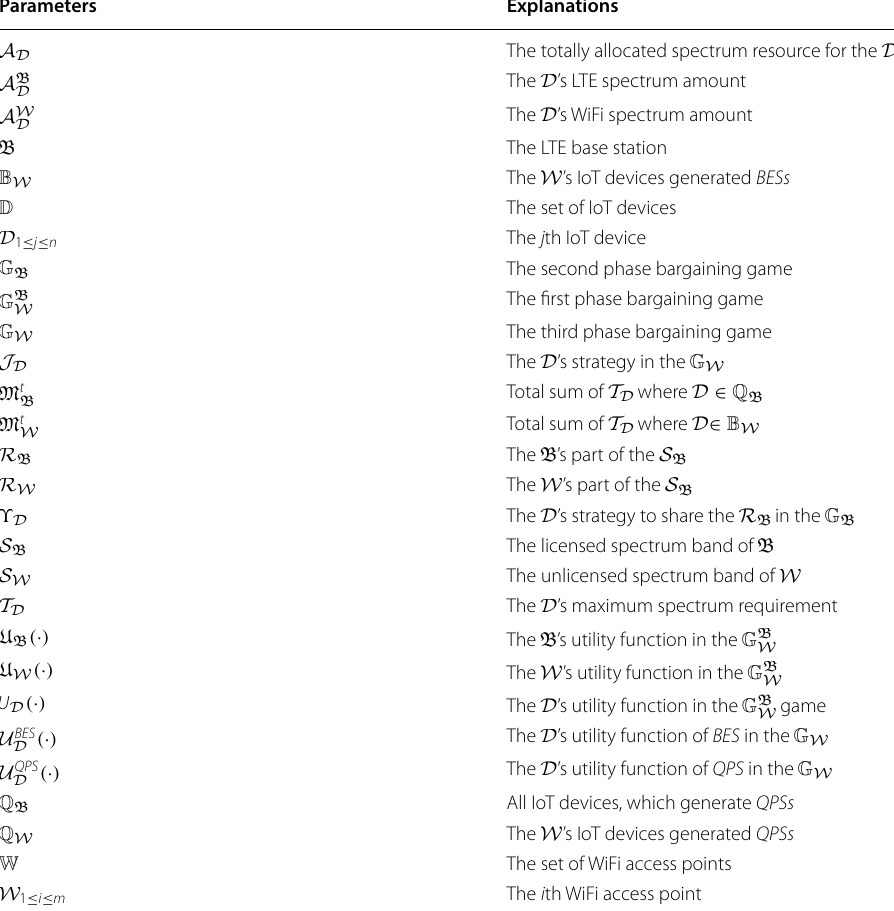
Table 1 Symbols and parameters for mathematical formulations